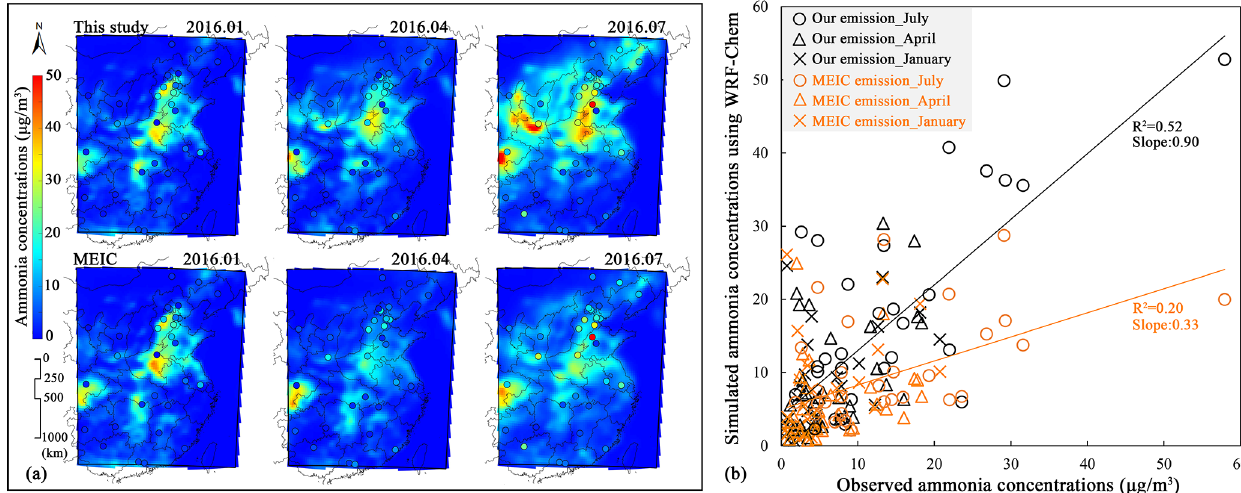
Figure 7. (a) Spatial distribution of NH 3 concentrations in 2016 from this study and the MEIC inventory. (b) Correlation between simulated NH 3 concentrations from different emission inventories and ground observations obtained from